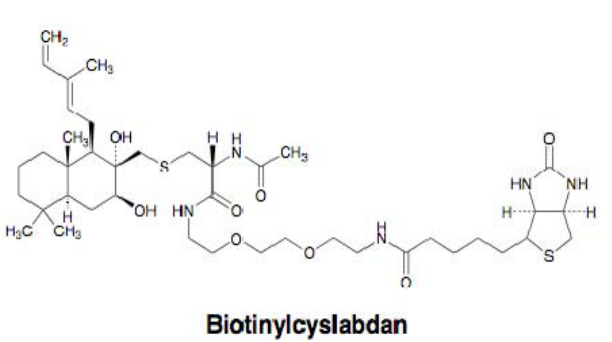
Figure 8. Structure of